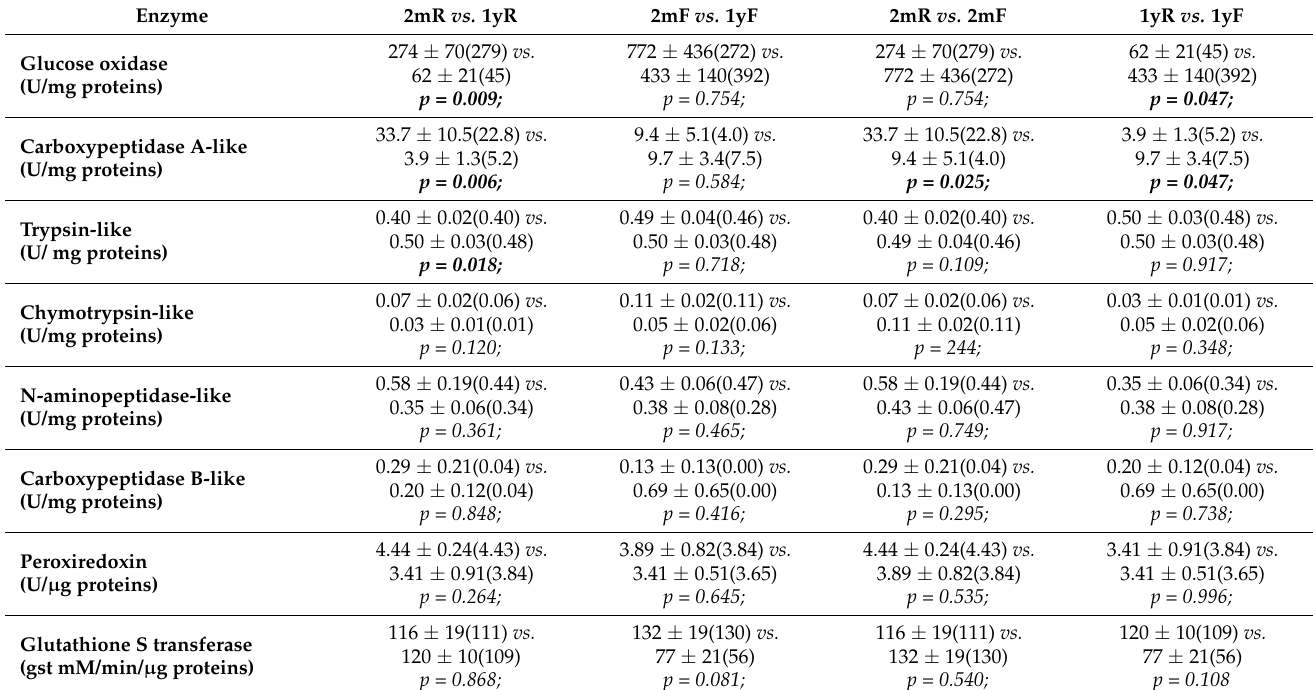
Table 3. Statistical differences in enzymatic activity in RJ samples refrigerated (R) at 4 ◦ C and frozen (F) at − 18 ◦ C for two months (2m) and 1 year (1y). All values are expressed as average ± SE (median). Significant differences are marked in